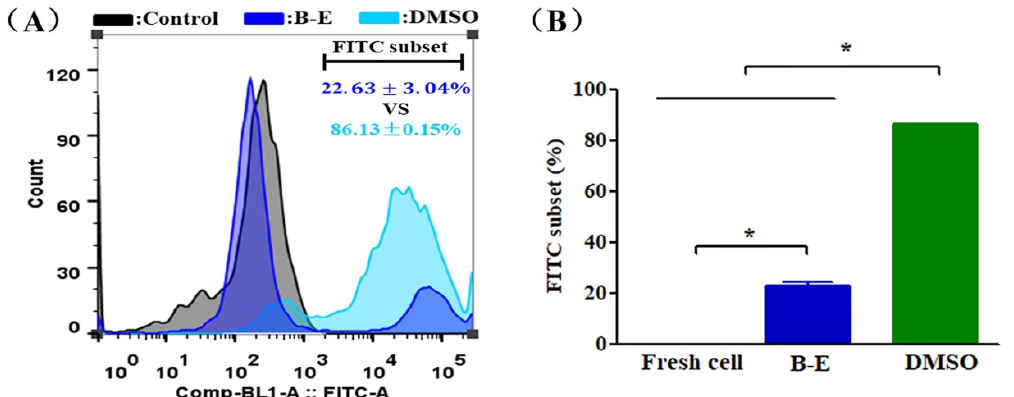
Figure 5. ROS level of UCMSCs. ( A ) Representative flow cytometry histograms of ROS level. ( B ) Flow cytometry quantification of FITC-positive cell population. Control group refers to UCMSCs without cryopreservation and staining process. Value = mean ± standard deviation, n = 3. * p < 0.05.